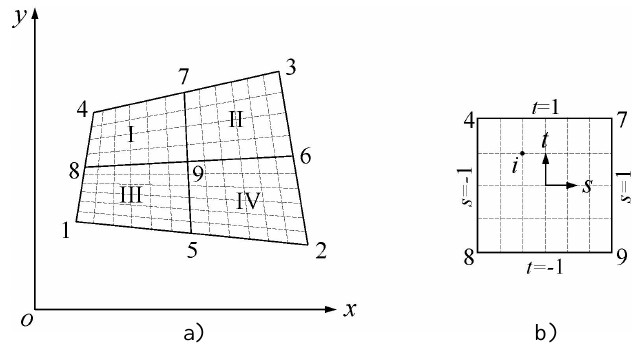
Figure 2. The finite element mesh of the interface and the local coordinate of sub-region. ( a ) global coordinate system; ( b ) local coordinate